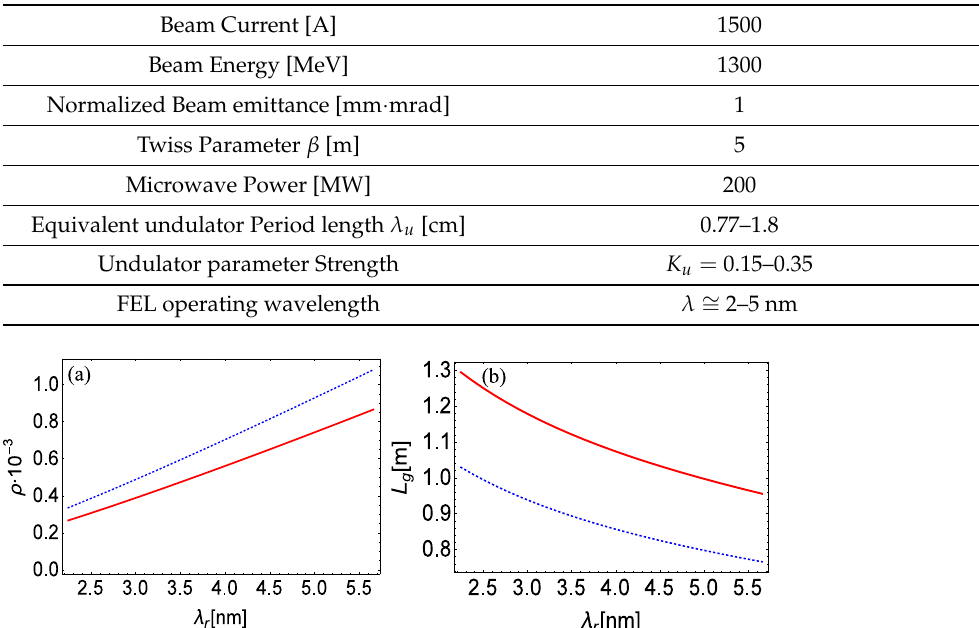
Table 3. Soft X-ray SASE MU-FEL operation.